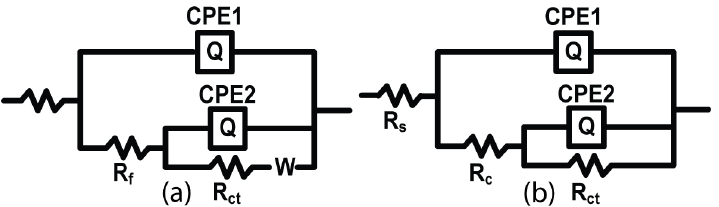
Figure 7. The equivalent circuit model used to fit the experimental data ( a ) for uncoated Cu and ( b ) for Cu/HEA coating in artificial seawater.